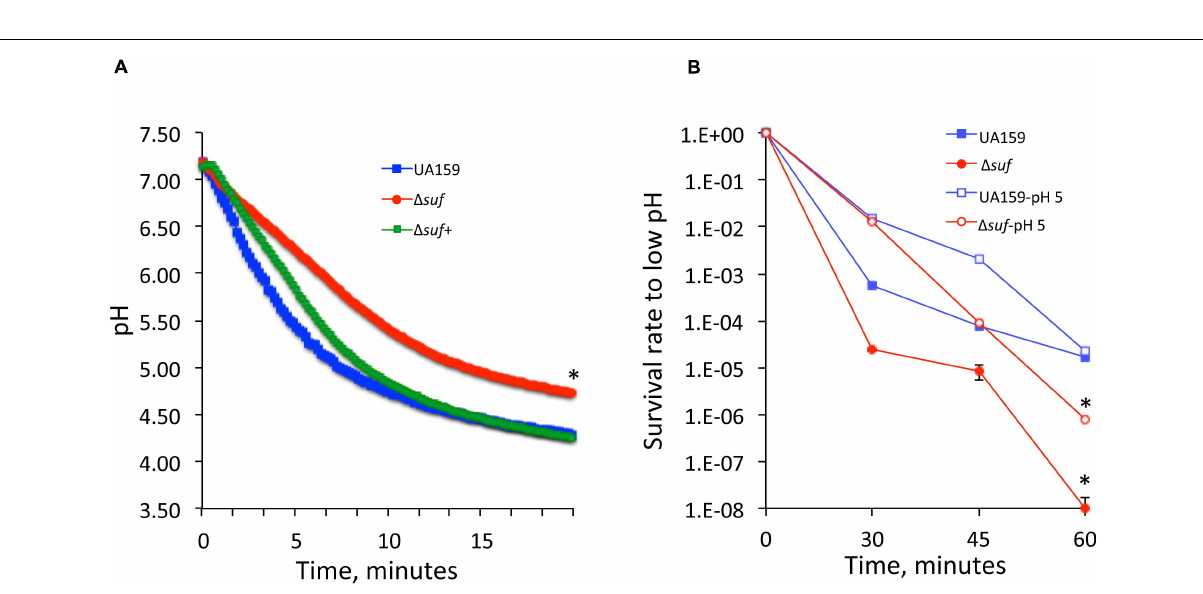
FIGURE 3 | Glycolytic pH drop analysis and acid killing assays. (A) Results of pH drop experiments showed that relative to wild-type UA159, the (cid:49) suf::kan r mutant ( (cid:49) suf ), had a significantly slower pH drop and a higher resting pH after 20 min (*, P < 0.05). Complementation with wild-type sufCDSUB in (cid:49) suf + was able to restore the phenotype to UA159. (B) When subjected to acid killing by incubation in buffer of pH 2.8, the survival rate of (cid:49) suf::kan r was reduced by 2-logs than wild-type (UA159) after 30 min and became virtually undetectable after 60 min. Although like UA159, it was able to increase its survival rate following pre-incubation at pH 5.0 for one hour. *, P <